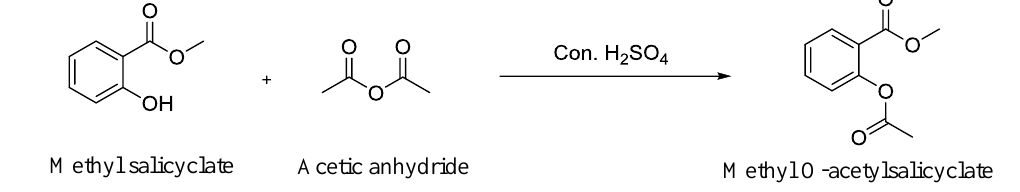
Figure 3. Reaction scheme for the synthesis of acetyl methyl salicylate